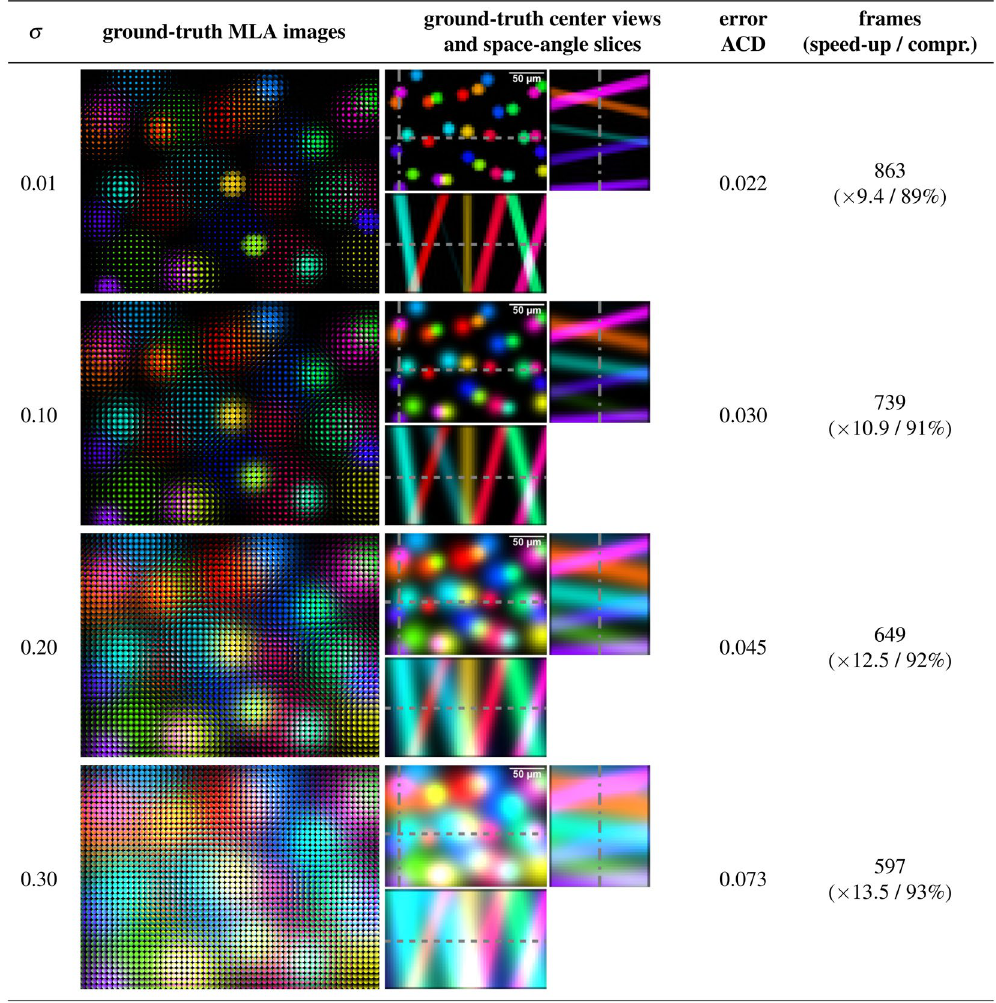
Figure 5. Simulated CVLE results with different amounts of scattering ( σ ). With increasing scattering, the signatures of individual particles become more isotropic, as shown in the MLA images and the center views with corresponding space-angle slices. The ACD between ground truth and reprojection represents only the error in the light-transport estimation, as we assume a perfect light-field factorization in this example. Results for simulated scattering are also shown in the supplementary